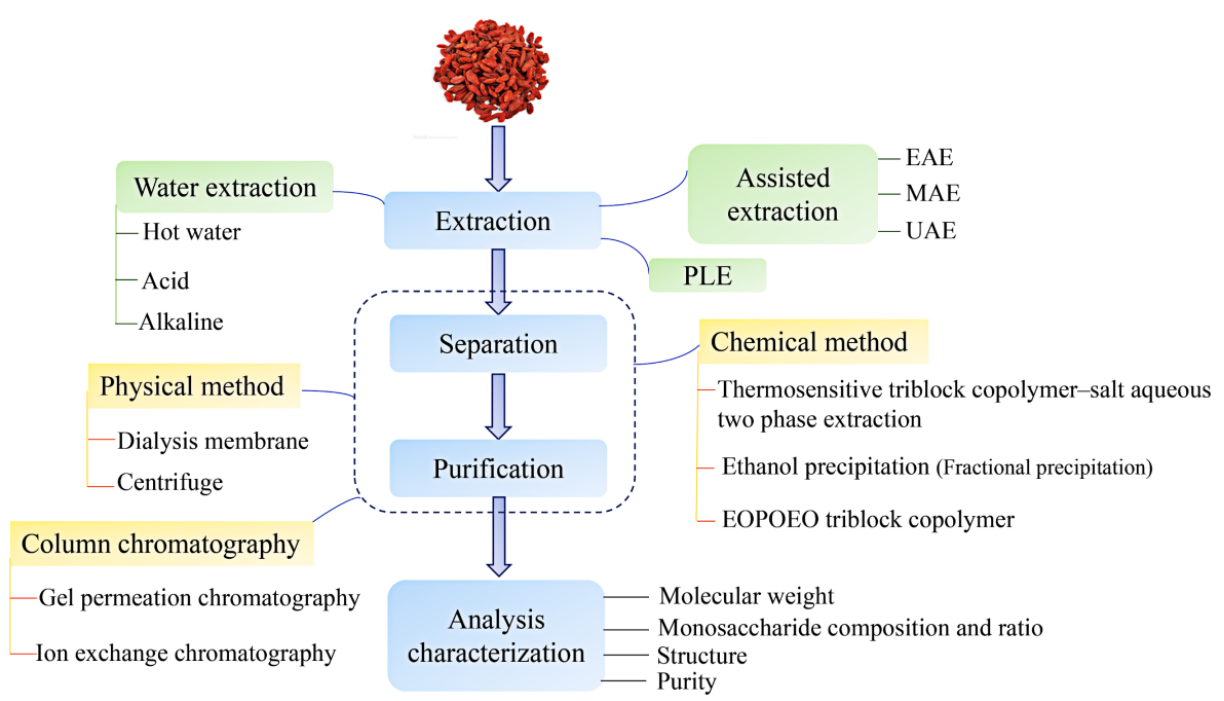
Figure 1. The characterization structure of LBPs. ( A) : the fresh fruit of L. barbarum ; ( B) : the dried fruit of L. barbarum ; ( C) : the monosaccharide composition in LBPs; ( D) : three representative structures of LBPs, including (1 → 6)- β -D-pyranogalac- tosyl, (1 → 3)- β -D-pyranogalactosyl, and (1 → 4)- α -D-pyranogalactosyl residues.